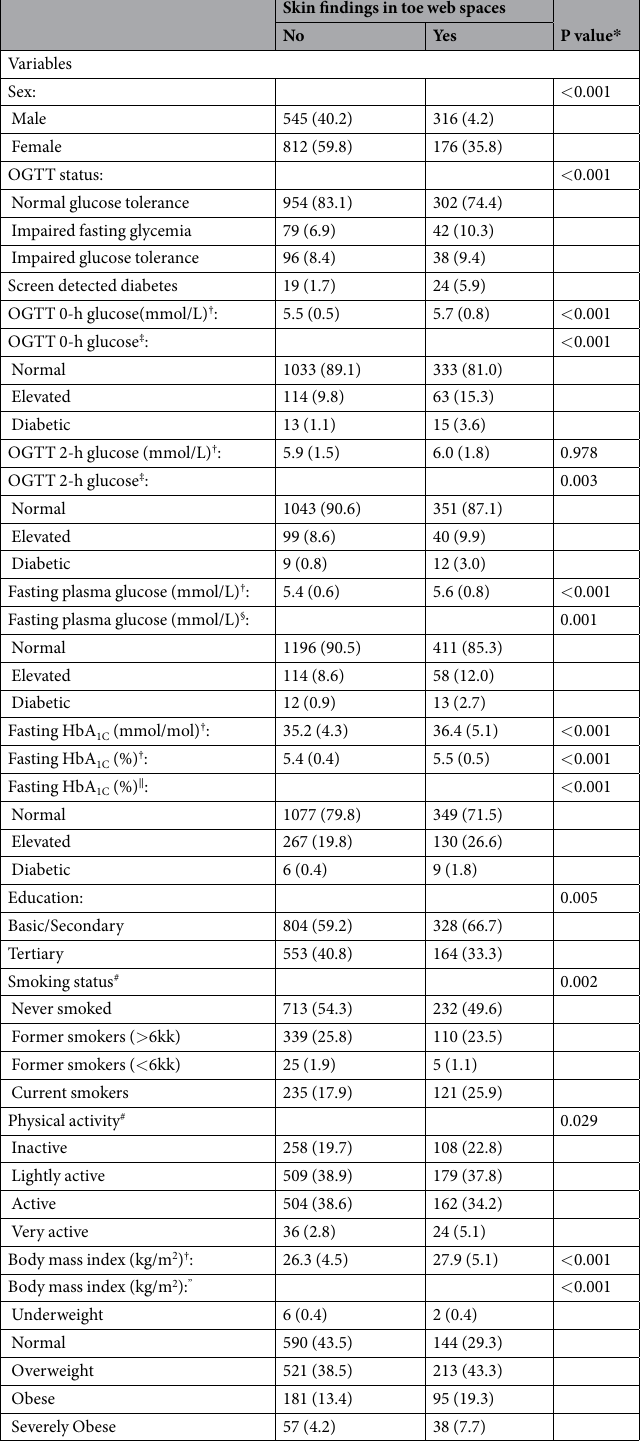
Table 2. Skin findings in toe web spaces and its associative factors. Values are numbers (percentages) of subjects unless stated otherwise. * The Mann-Whitney U-test for used when testing continuous variables and Chi-Square test or Fisher exact test for categorical variables. † Values are mean (standard deviation, SD). ‡ OGTT: 1,571 study cases first attended and 1,554 of them completed OGTT. OGTT was not conducted if FPG was < 8.0 mmol/l just before the test (n = 11). OGTT 0-h or OGTT 2-h was not eligible in six (n = 6) study cases. N = 278 did not attend the OGTT. § Data of FPG was missing from n = 45. ǁ Data of HbA1c was missing from n = 11. # Data of smoking status and physical activity was missing from n = 69 (The reason was missing data was that all study cases did not fill health questionnaires). ” Data of body mass index was missing from n = 2 (The reason for missing data was that all study cases did not come to the